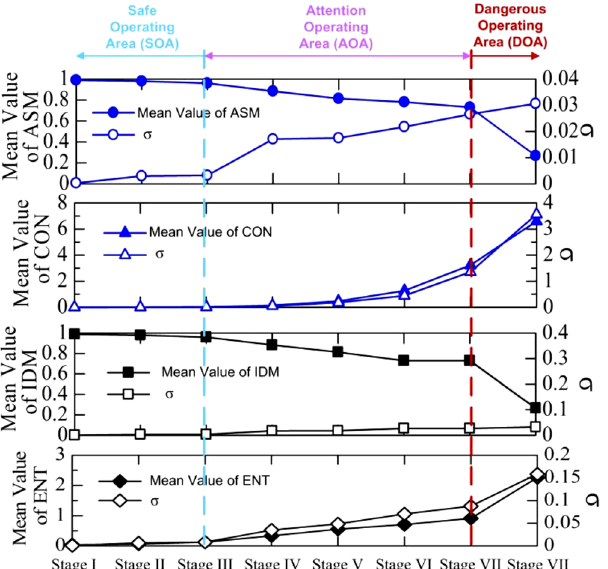
Figure 6. Mean value of quantitative indicators (ASM, CON, IDM, ENT) of arc discharges during the flashover process of iced